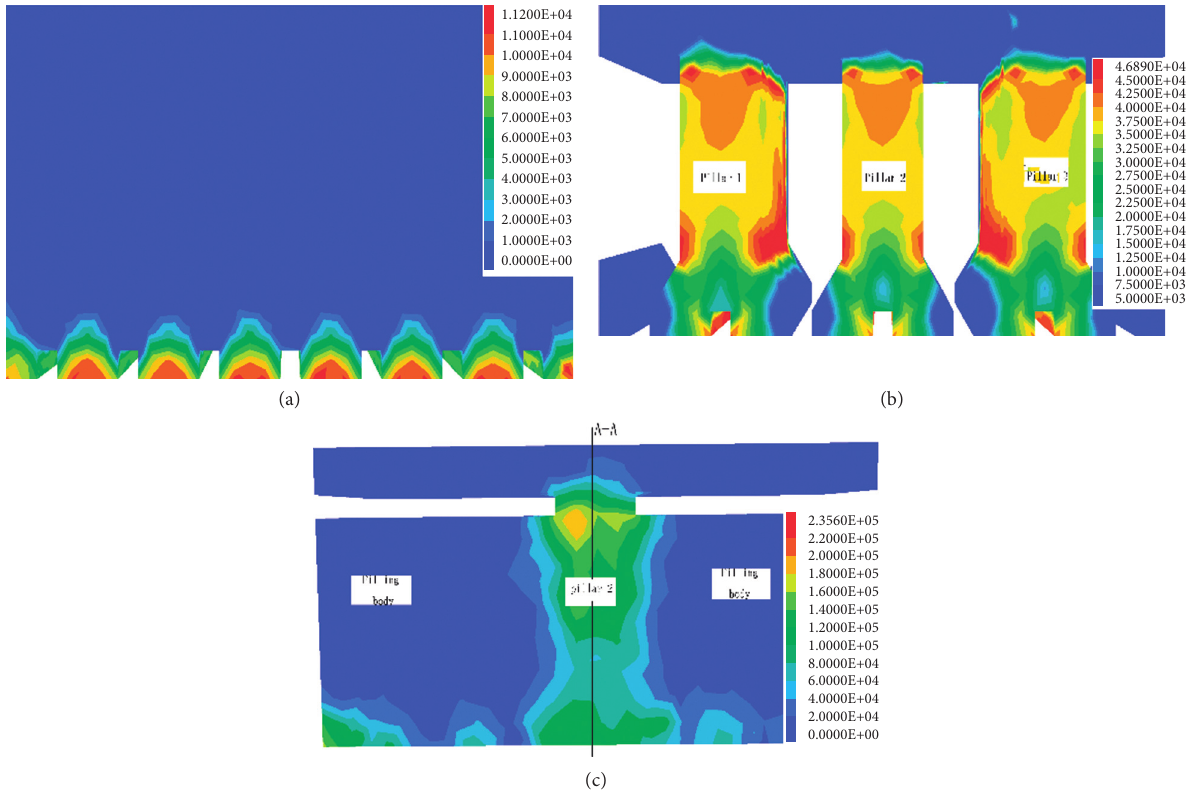
Figure 3: Energy density distribution in each stage of stoping. (a) Energy distribution after the formation of the exit roadway. (b) Energy distribution after mining. (c) Energy distribution before excavation of cutting groove.